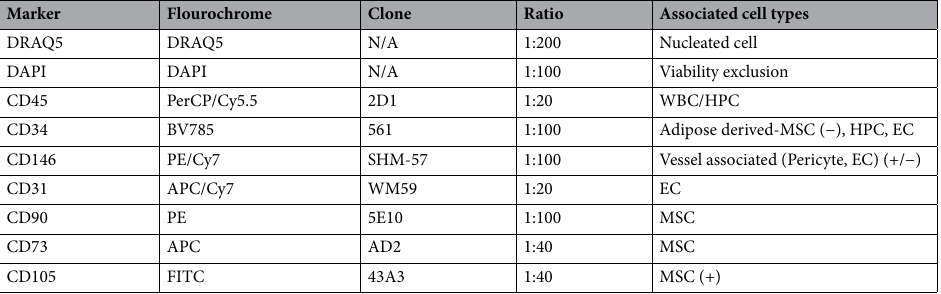
Table 1. Summary of markers used and associated cell types. All antibodies were purchased from BioLegend (San Diego, CA) and respective catalog numbers are shown. MSC mesenchymal stromal cell, HPC hematopoietic progenitor cell, EC endothelial cell. Symbols indicate expression (−) lost or (+) gained in culture 1,6,8–11 .